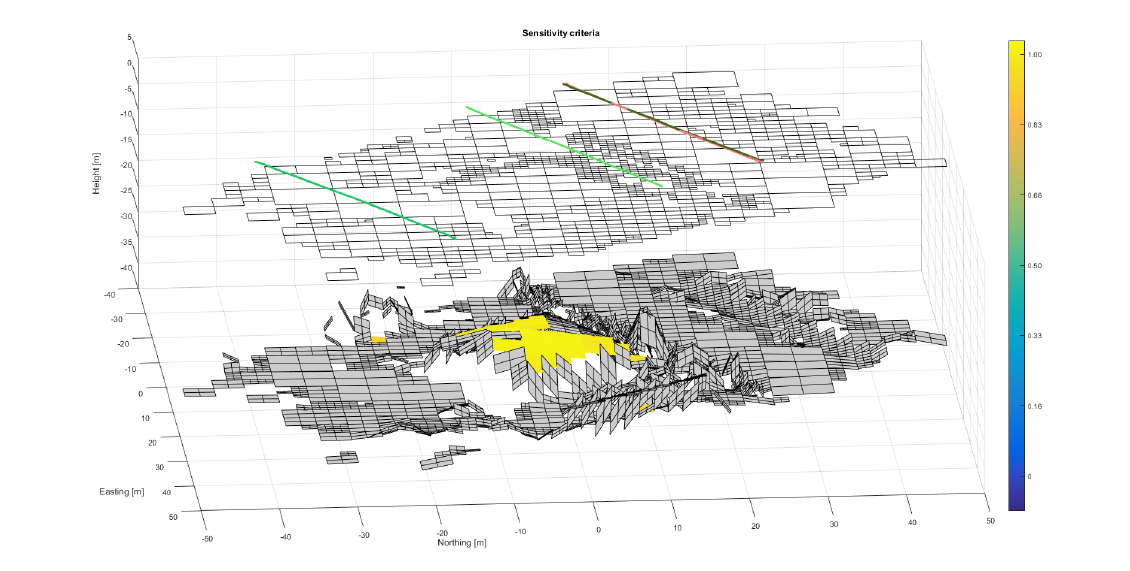
Figure 8. Results of data selection (quad-tree and sensitivity criterion) on the point cloud presented in Figure 7. Yellow patches correspond to selected surface elements. On the top, the green and brown lines represent that calibration